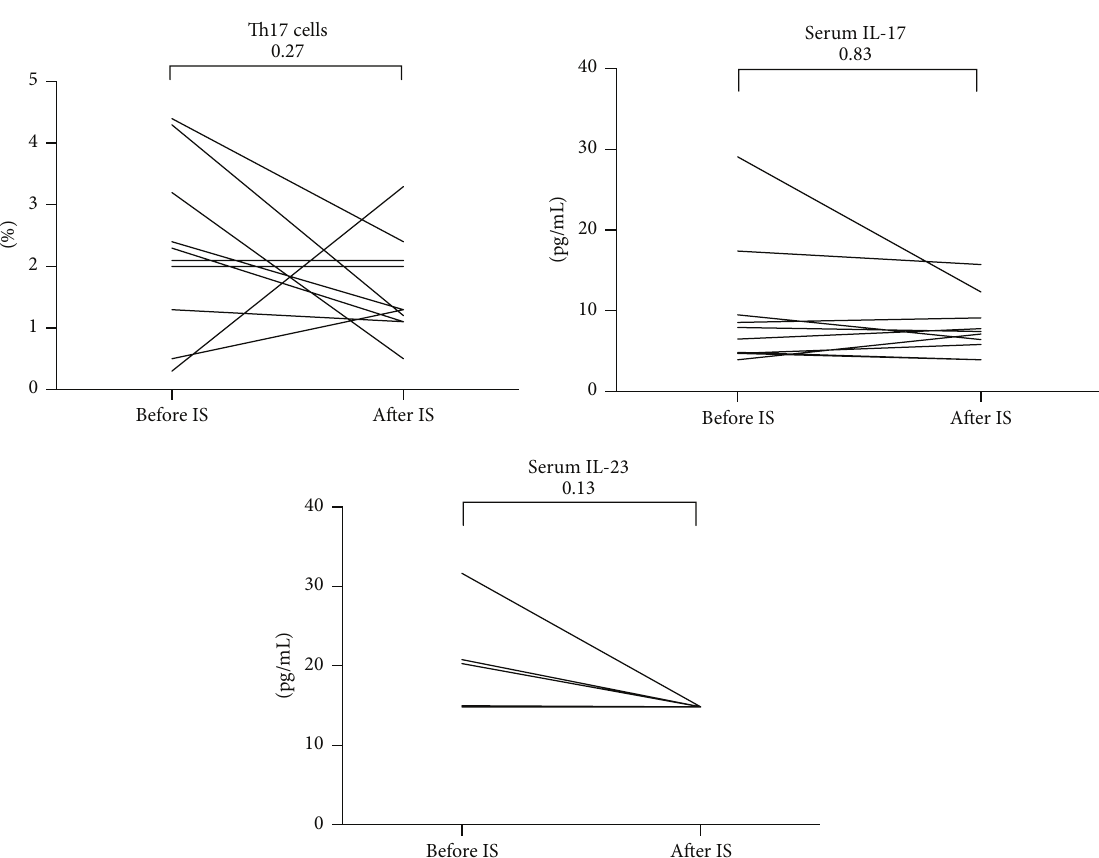
Figure 4: For the subgroup of 10 patients who were immunosuppressive- (IS-) na¨ıve and were started on treatment (prednisolone and methotrexate),T-helper17(Th17)cellsandserumIL-17AandIL-23beforeand3monthsaftertherapywererecorded.Therewerenosignificant differences. Serum IL-23 was detectable in 3 patients prior to immunosuppression and in none of them after. 𝑝 value (Mann-Whitney test) is mentioned in each figure.